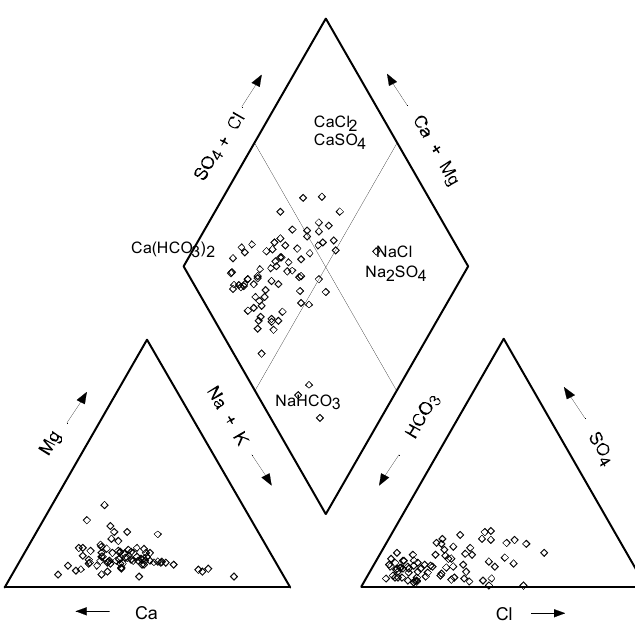
Figure 1. A Piper diagram showing various water types in the Icheon groundwater.